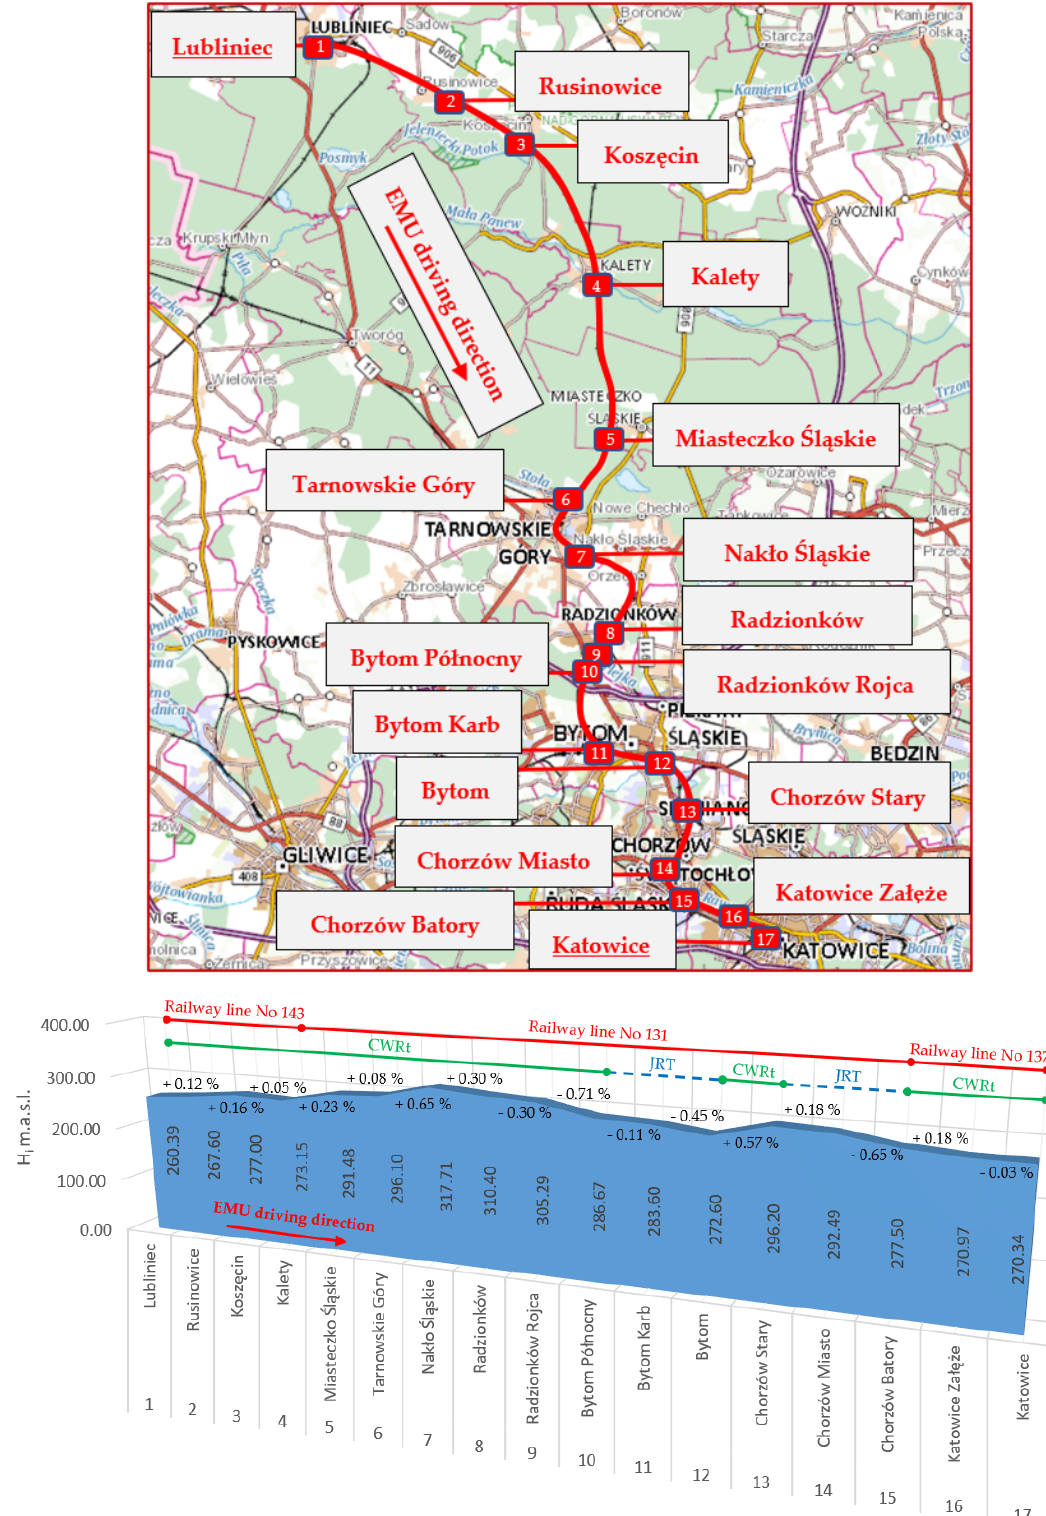
Figure 1. Exposure of route geometry in the plane: ( a ) situational; ( b ) elevation–longitudinal profile, length of 62.741 km, where: 1–17 are passenger stops or stations; EMU—electric multiple unit; H i —elevation coordinate expressed in the state spatial reference system in [m.a.s.l.]; CWRt—continuous welded rail track; JRT—jointed railway track.